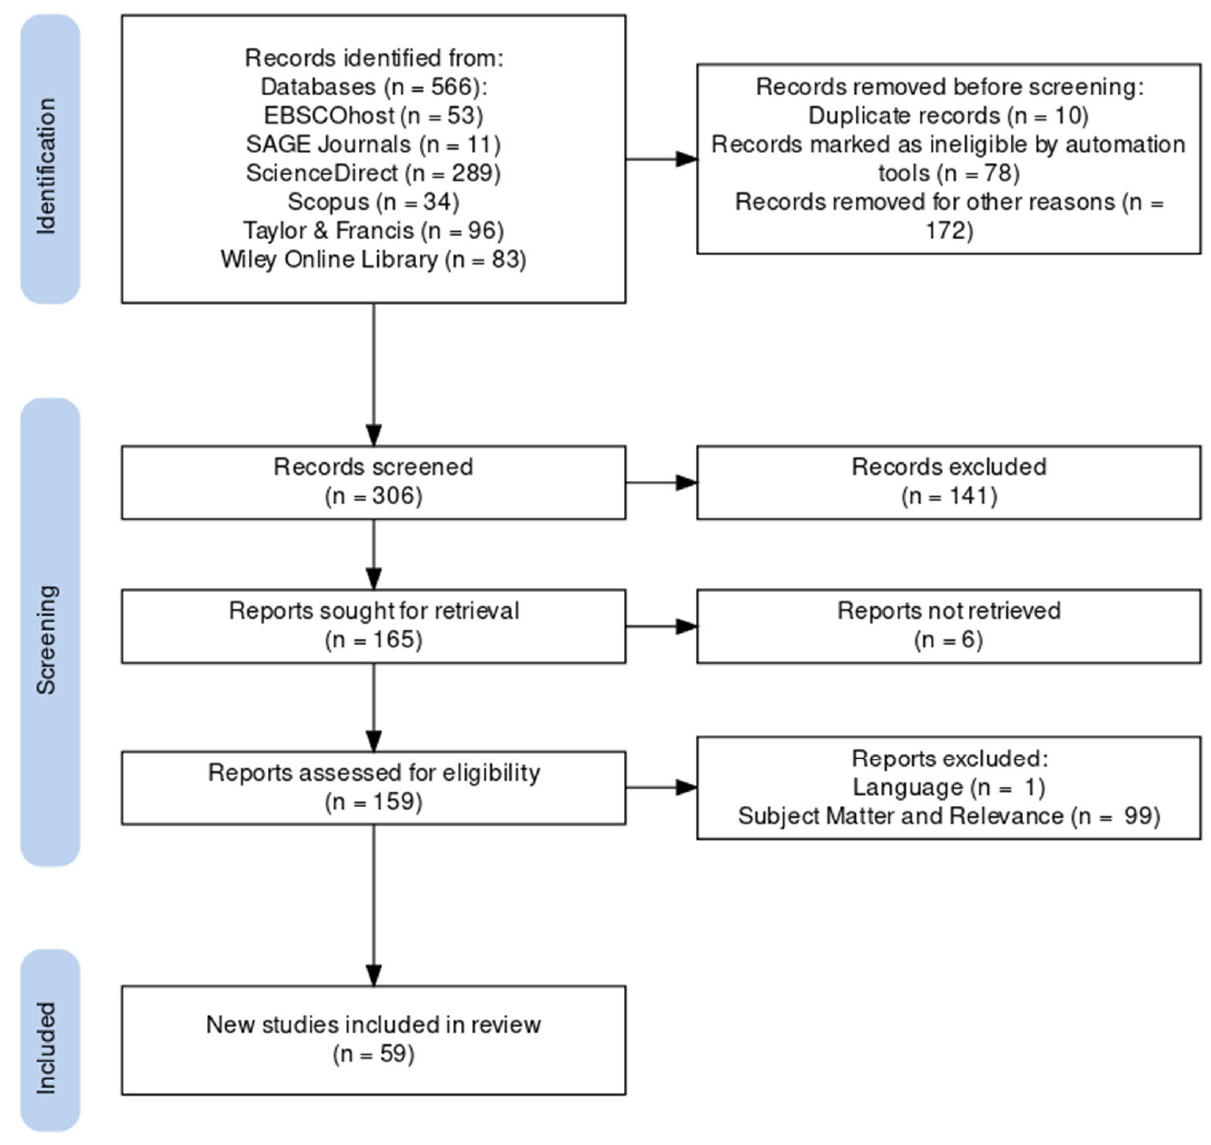
Figure 1. PRISMA article screening workflow. Table 2. Coding scheme used for data